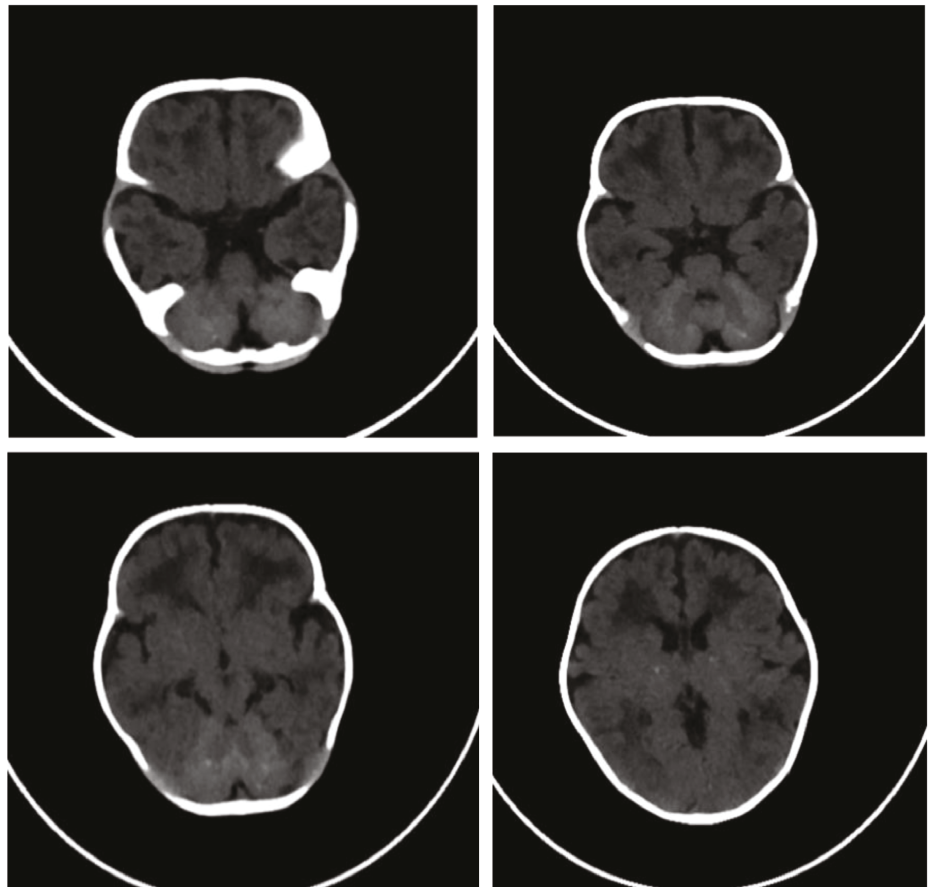
Figure 1: Brain CT scan: diffuse calcifications involving both lobes as well as basal ganglia and extensive bilateral periventricular